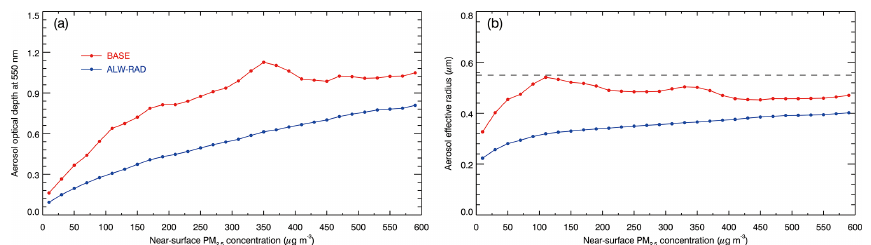
Figure 7. Average variations in (a) AOD and (b) Reff in f base (red line) and f alw_rad0 (blue line) as a function of bin [PM 2 . 5 ] in NCP during daytime from 5 December 2015 to 4 January 2016.